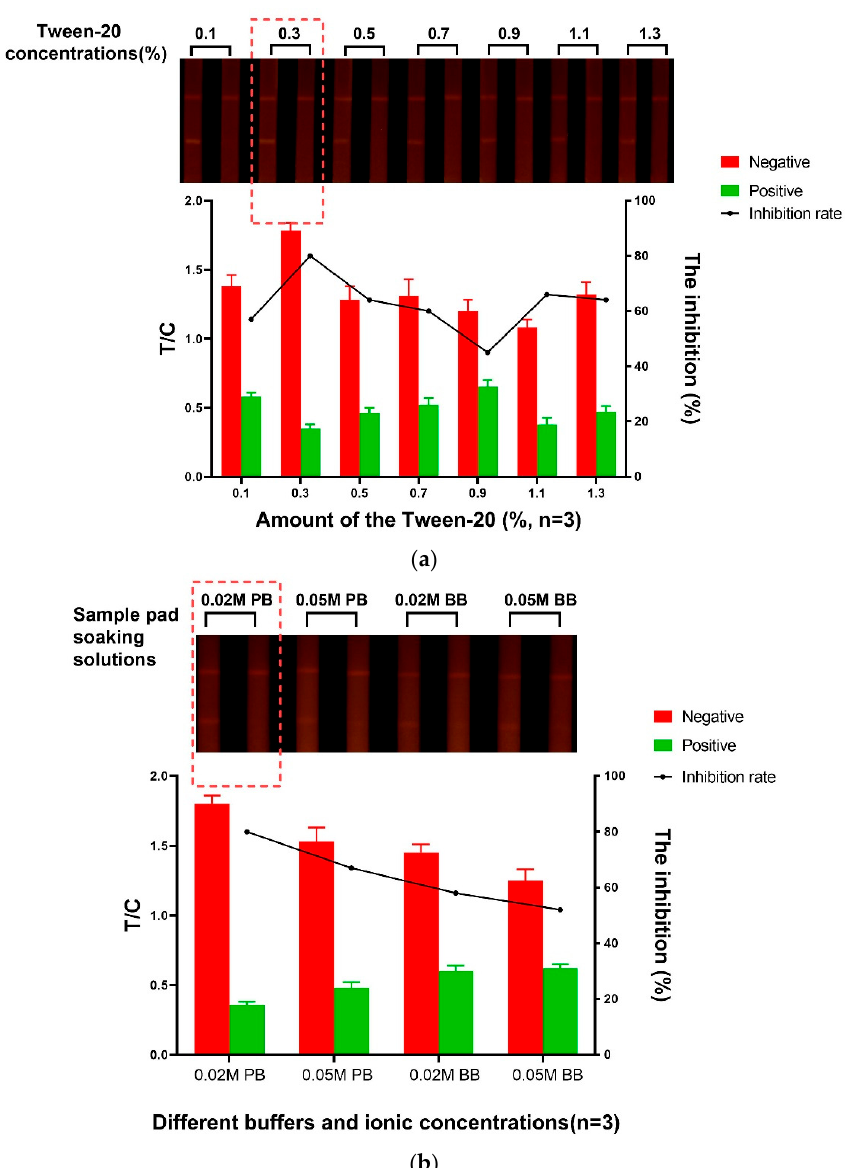
Figure 3. The fluorescence intensity, inhibition effect, and inhibition rate of the Sample pad treat- ment: ( a ) Tween-20 concentration; ( b ) The different sample pad soaking solutions. ( a ) Tween-20 concentration; ( b ) The different sample pad soaking